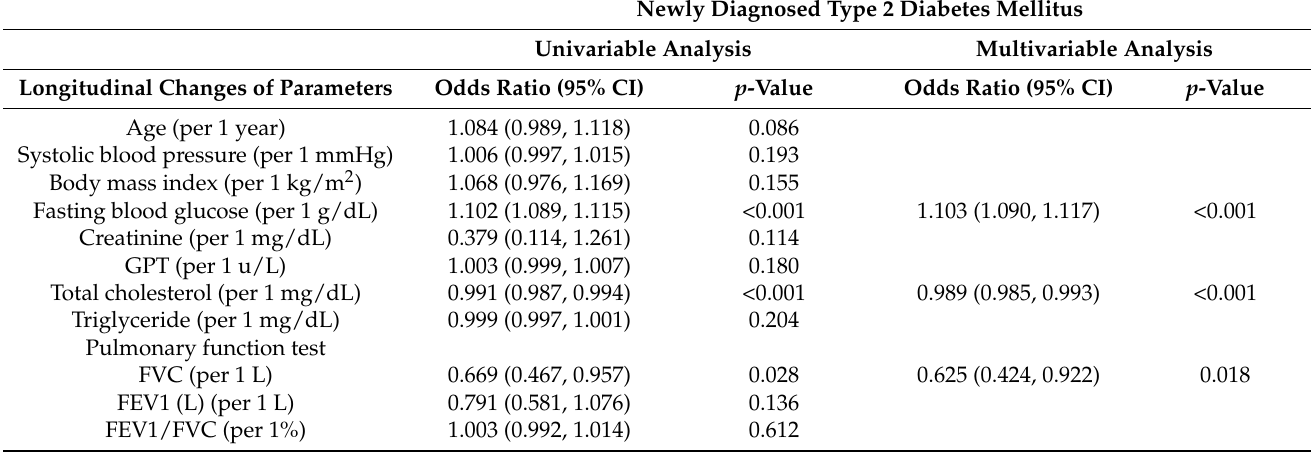
Table 6. Odds ratio of longitudinal changes of parameters in association with newly diagnosed type 2 DM in univariable and multivariable logistic regression